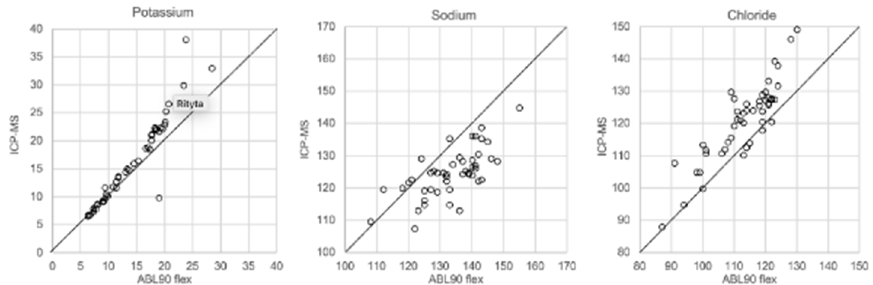
Figure 3. Comparison of ABL90 flex and ICP-MS.